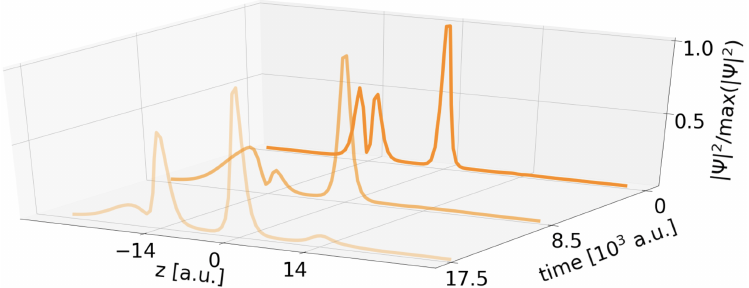
Figure 7. Illustration of the electron density distribution weighted to its maximal value for three propagation timesteps. The initial wavefunction has electron density corresponding to two electrons in one A ∗ state and in B separated by R AB = 14a.u., but no density in the other A site. CICD was already excluded by rationalization, hence, of the other subprocess,